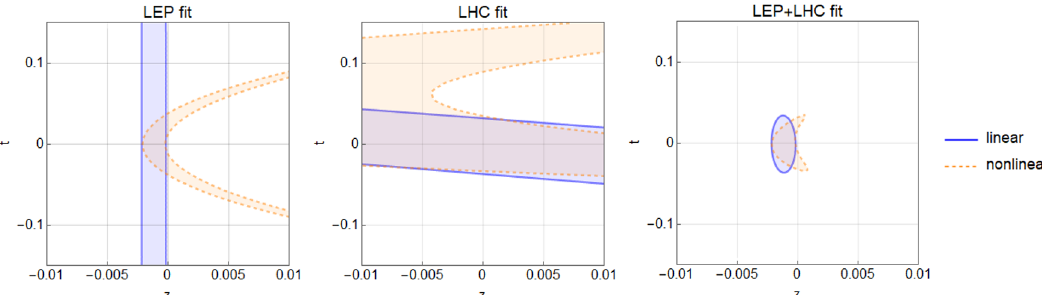
Figure 3 . Comparison between linear and nonlinear contours ( ∆ χ 2 = 1 ) in a 2D fit using the “traditional” pole observables discussed in section 3 (LEP fit, left panel), the ATLAS FB asymmetry data (LHC fit, central panel) and the combination of both (right